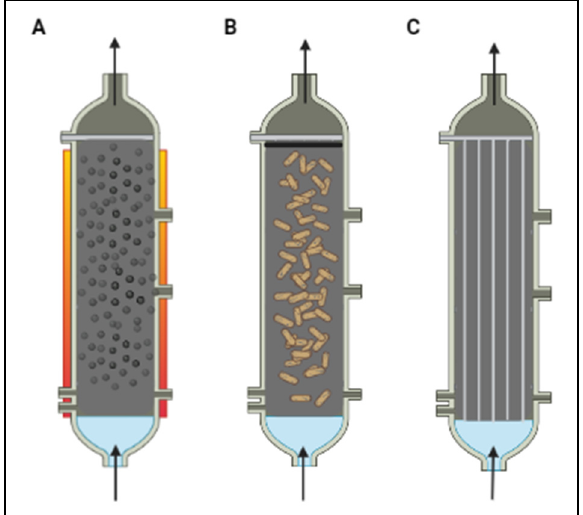
Figure 4. Photocatalysis reactor configuration: ( A ) free NPs separated from the water via a magnetic field; ( B ) NPs immobilized on macroscopic particles (fixed or fluidized bed); ( C ) NPs immobilized on membranes.